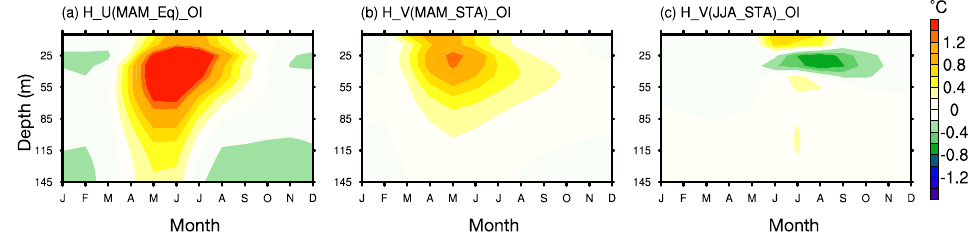
Figure 10. Depth-month distribution of the area-averaged temperature bias (unit: °C) over the ACT region during 1979–2005 for H_U(MAM_Eq)_OI ( a ); H_V(MAM_STA)_OI ( b );and H_V(JJA_STA)_OI ( c ).